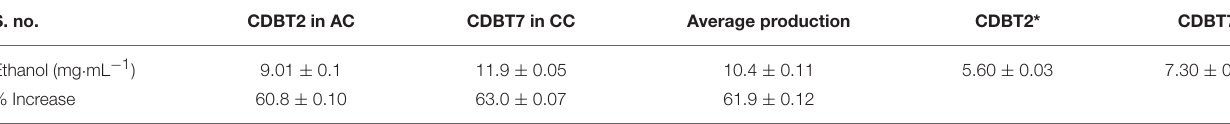
TABLE 3 | Ethanol produced by CDBT2 and CDBT7 cultured with lignocellulosic biomass hydrolysate. S.